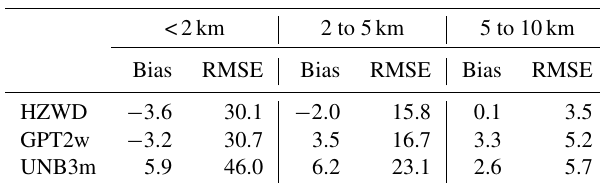
Table 3. Error statistics for the three models validated by 2015 ra- diosonde data (unit: